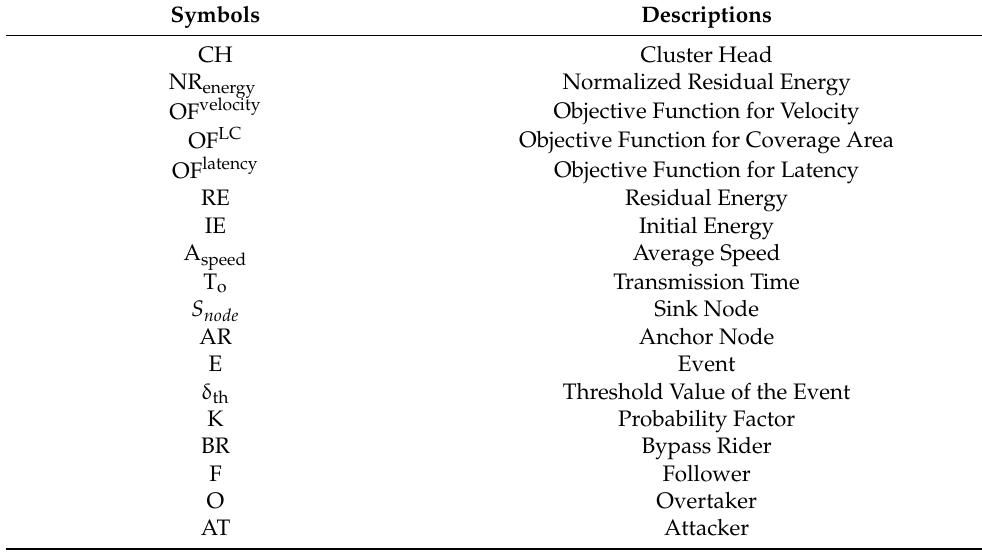
Table 2. Communication Model.